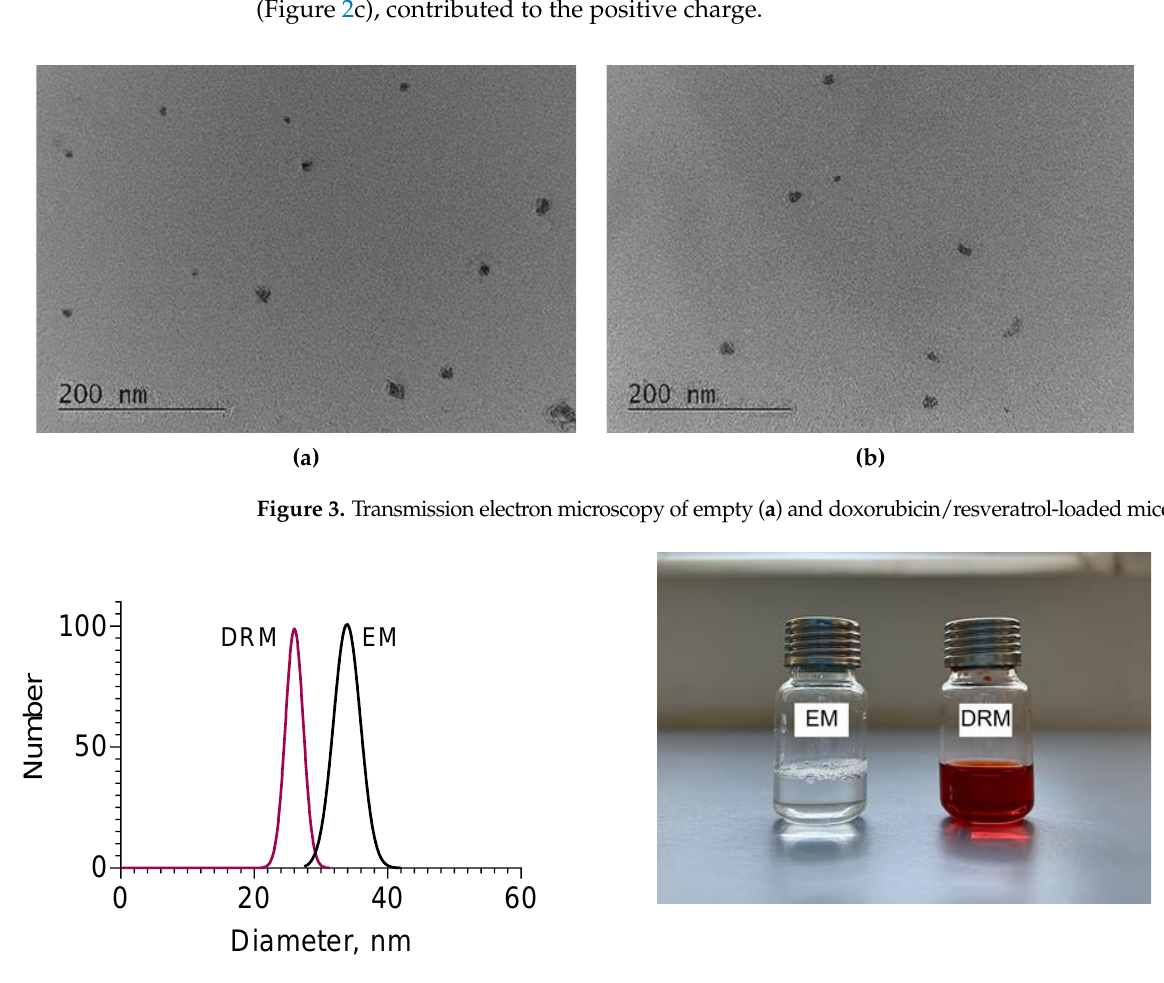
Figure 4. Mean diameters ( a ) and digital image ( b ) of empty (EM) and double-loaded doxorubicin/resveratrol micelles (DRM).